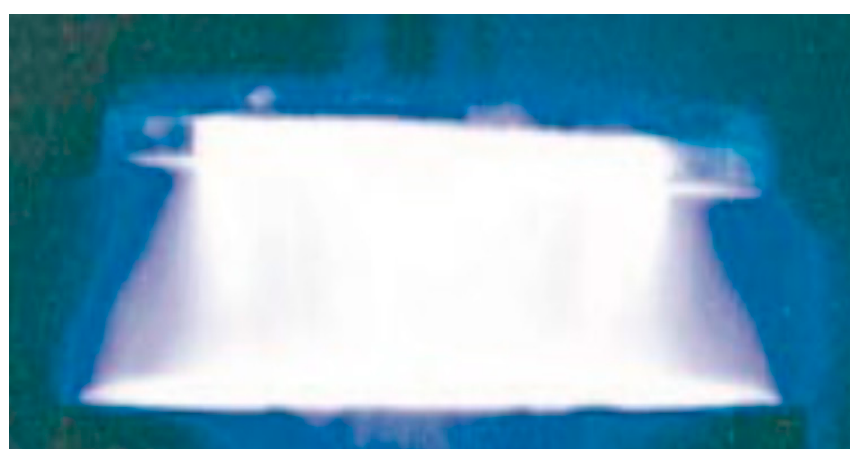
Figure 1. Schematic of the resistive barrier discharge.